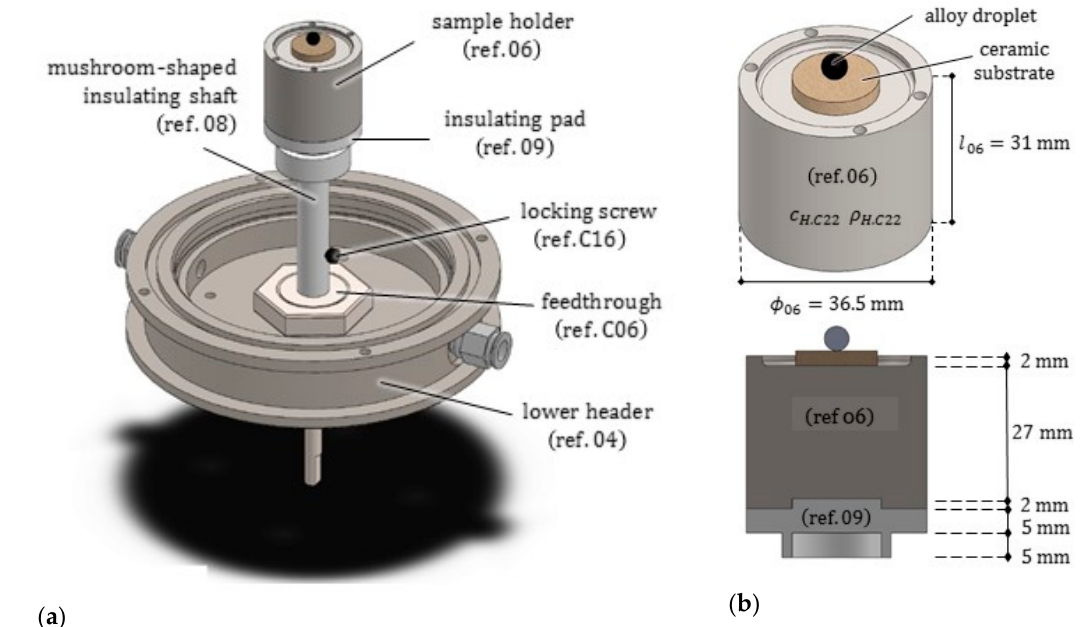
Figure 7. ( a ) Axonometric view of the rotating sample holder and of its transmission system. The lower header (ref. 04) of the furnace stands still during scanning. ( b ) The sample holder and its longitudinal radial section, from which the insulating pad (ref. 09) can be recognized.